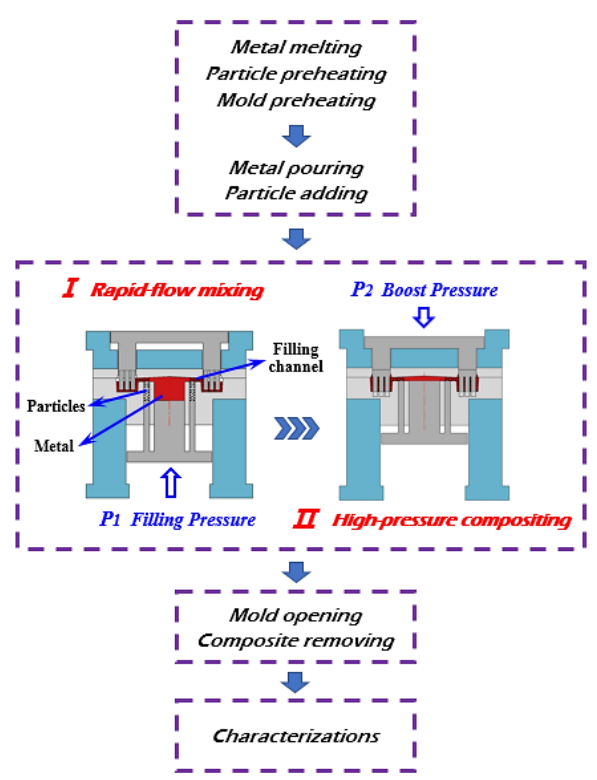
Figure 1. Schematic diagram for fabricating the composite by two–step process.